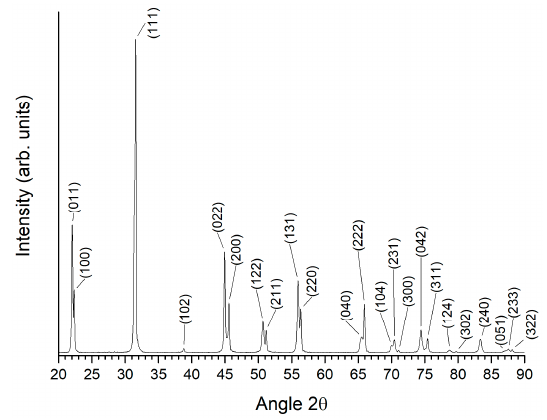
Figure 1. XRD pattern of calcined KNbO 3 powder.